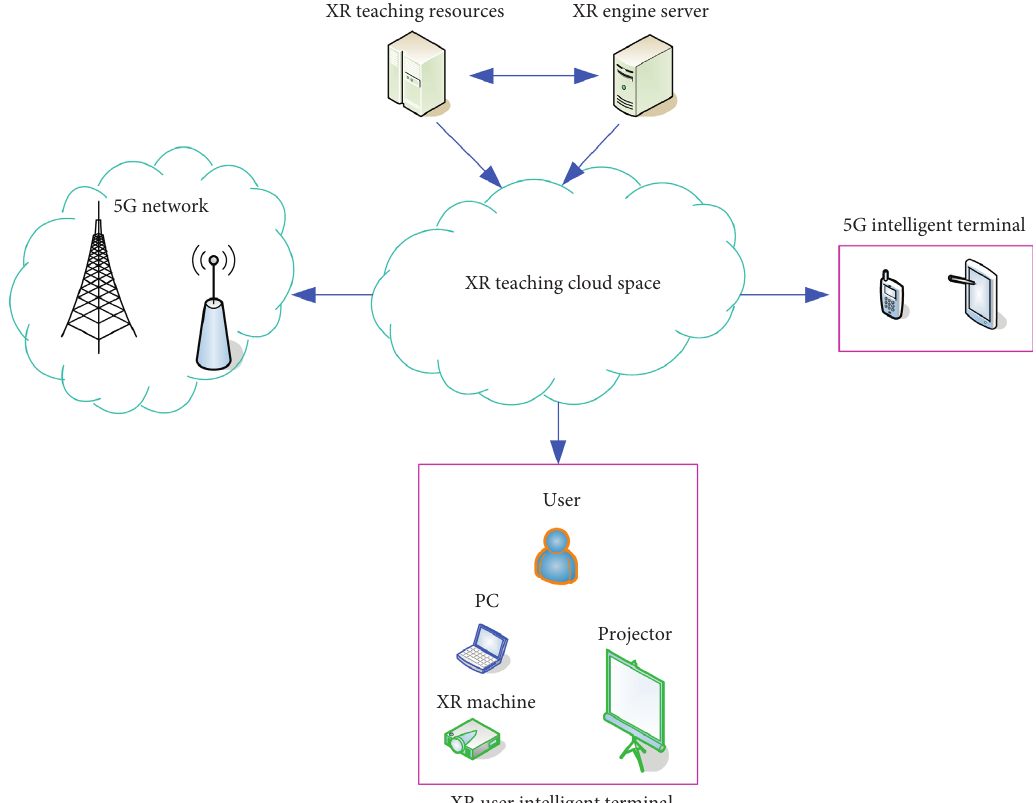
Figure 7: Construction diagram of 5G+XR education cloud